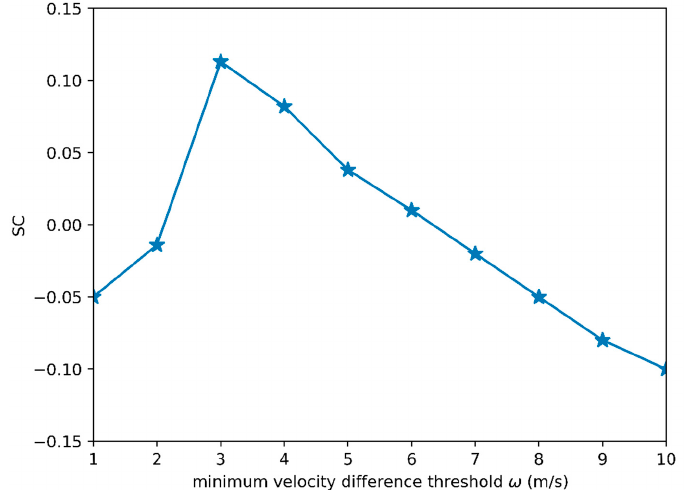
Figure 4. Comparison experimental results with di ff erent minimum velocity di ff erence